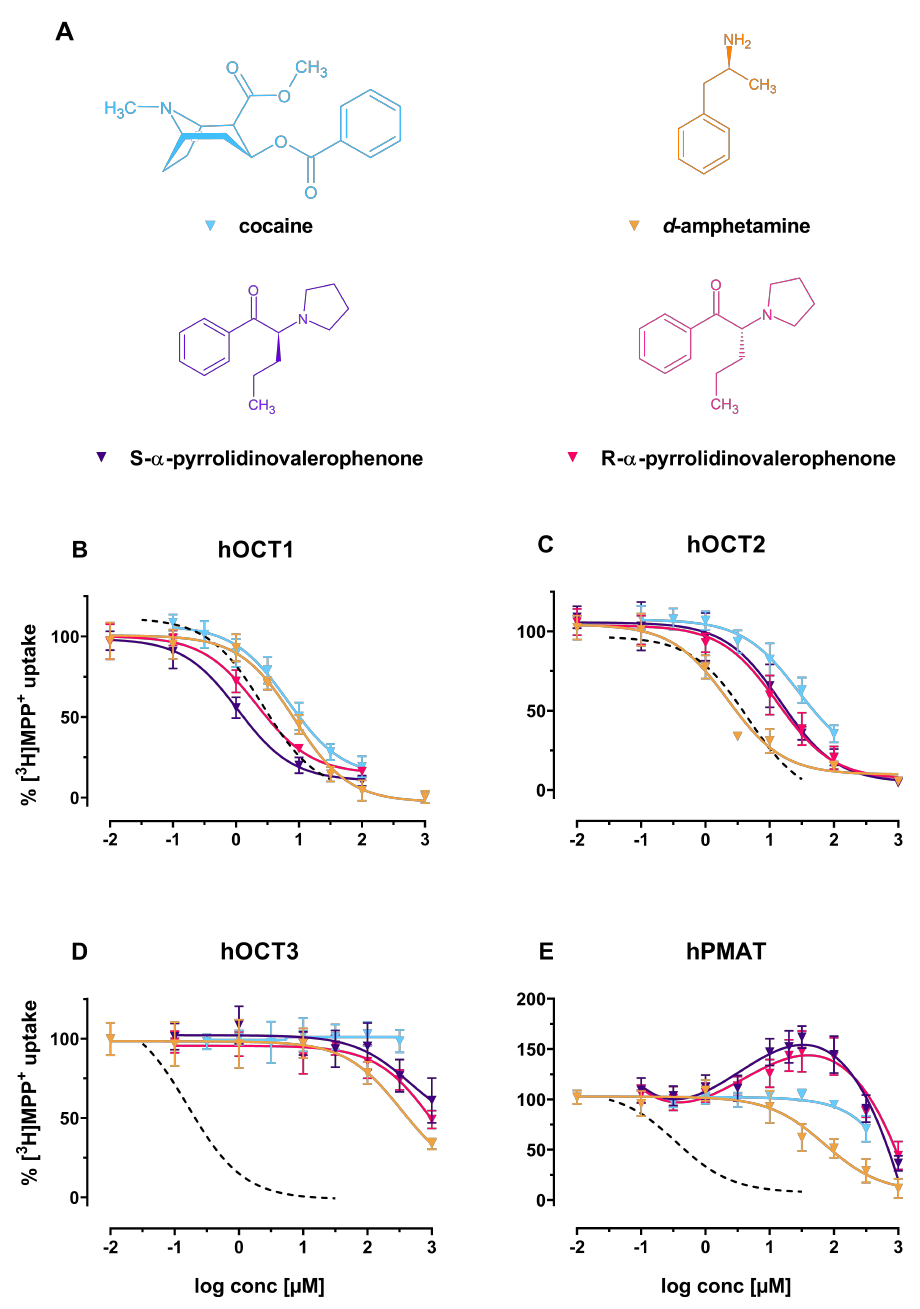
Figure 4. ( A ) Chemical structures of the herein investigated psychostimulants. From left to right: cocaine (blue), d -amphetamine (yellow), S- α -pyrrolidinovalerophenone (violet) and R- α - pyrrolidinovalerophenone (red); ( B – E ): Effects of the above-mentioned compounds (including decynium- 22; dashed line) on ( B ) hOCT1, ( C ) hOCT2, ( D ) hOCT3 and ( E ) hPMAT of uptake of tritiated MPP + in HEK293 cells stably expressing the respective